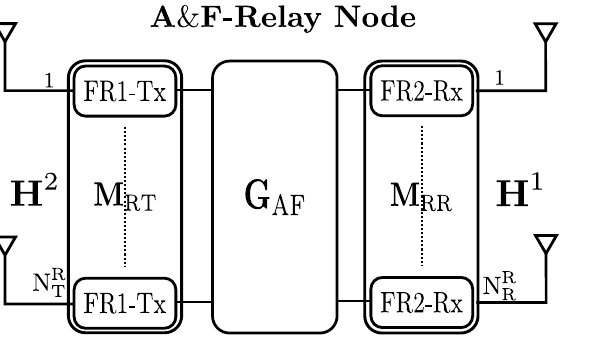
Figure 3. Uplink mmWave MIMO new radio amplify-and-forward relay node